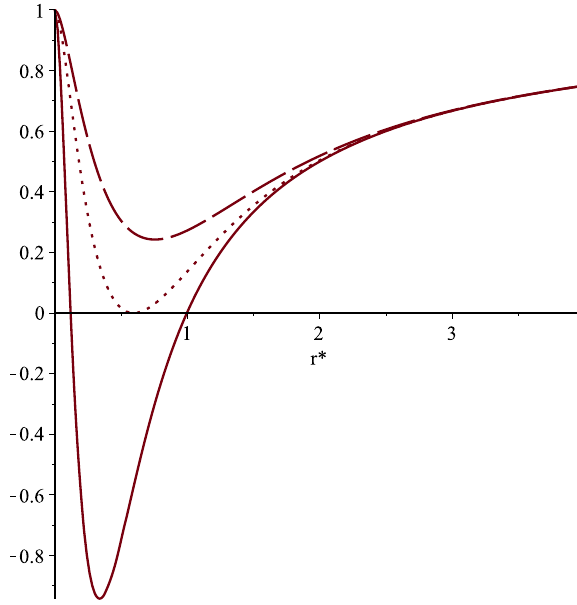
Fig. 10 Plot of the metric coefficient g 00 given by (33) in the case H = 0 . 1 and μ = 5 for ξ = 1 (solid line), ξ = 1 . 2865 (dot line) and ξ = 1 . 4 (longdashed line). Note that for ξ = 1 the event horizon is at r ∗ = 1 and coincides with that of a Schwarzschild black hole. The extreme black hole corresponds to ξ = 1 . 2865 and its event horizon is located at r ∗ e = 0 . 5947 or equivalently at r e = 2 . 33 × 10 − 7